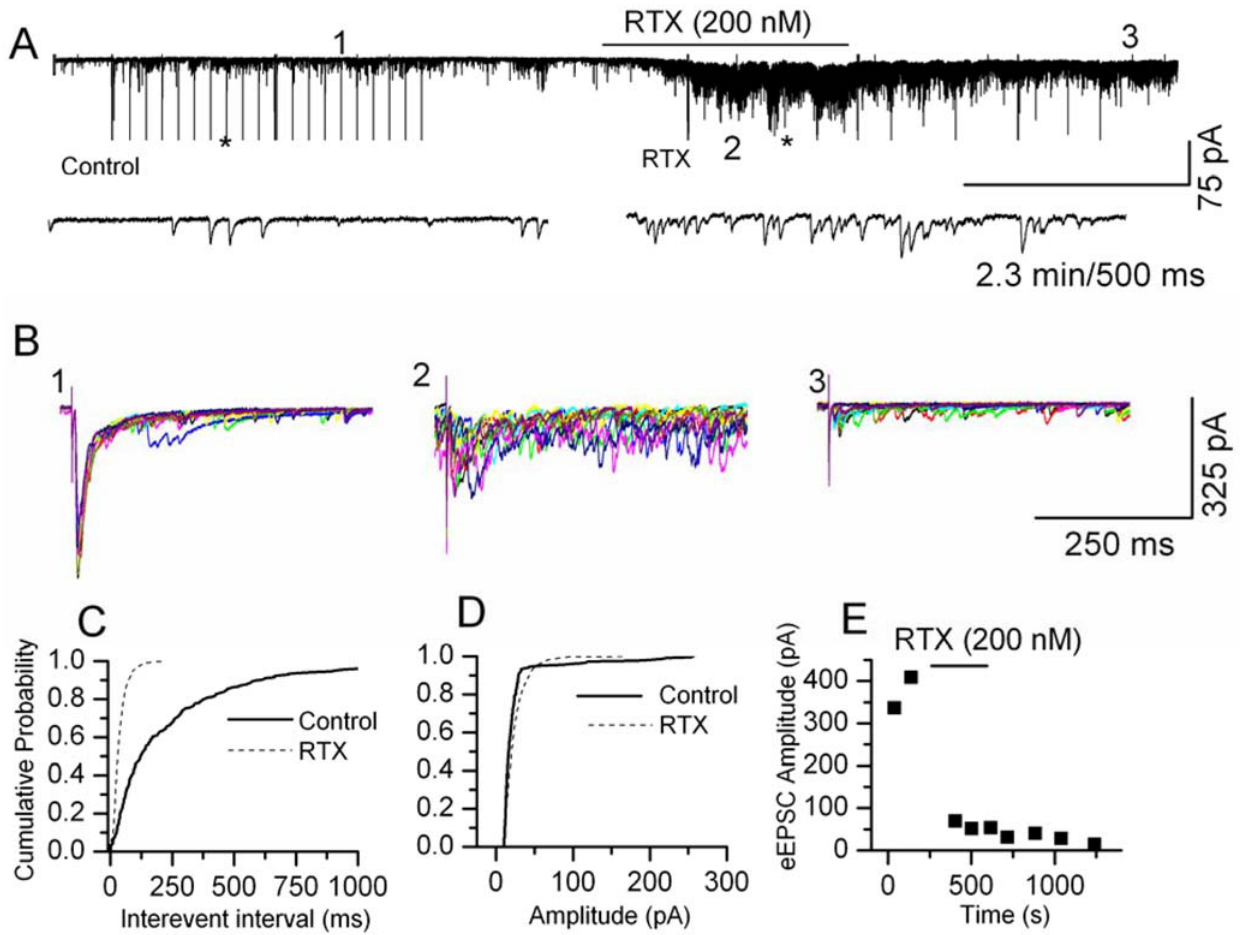
Figure 2. Modulation of synaptic transmission by RTX at the first sensory synapse in the spinal cord. A. Application of RTX (200 nM) increased the frequency of sEPSCs. RTX-induced response showed a slower onset and lesser deactivation/desensitization. The evoked responses are truncated. The synaptic events are shown at a higher time resolution below (the regions denoted by asterisks). B. Superimposed traces (10) of evoked synaptic responses recorded at three different time points from the same neurons. In the presence of RTX eEPSCs either failed or exhibited a reduction in amplitude. C. Cumulative probability plot showing decreased inter-event intervals representing increased frequency of sEPSCs ( p , 0.0001, KS test). D. The increase in frequency was not accompanied by a significant change in the amplitude. E. The reduction or failure of eEPSC amplitude remained suppressed even after washout.